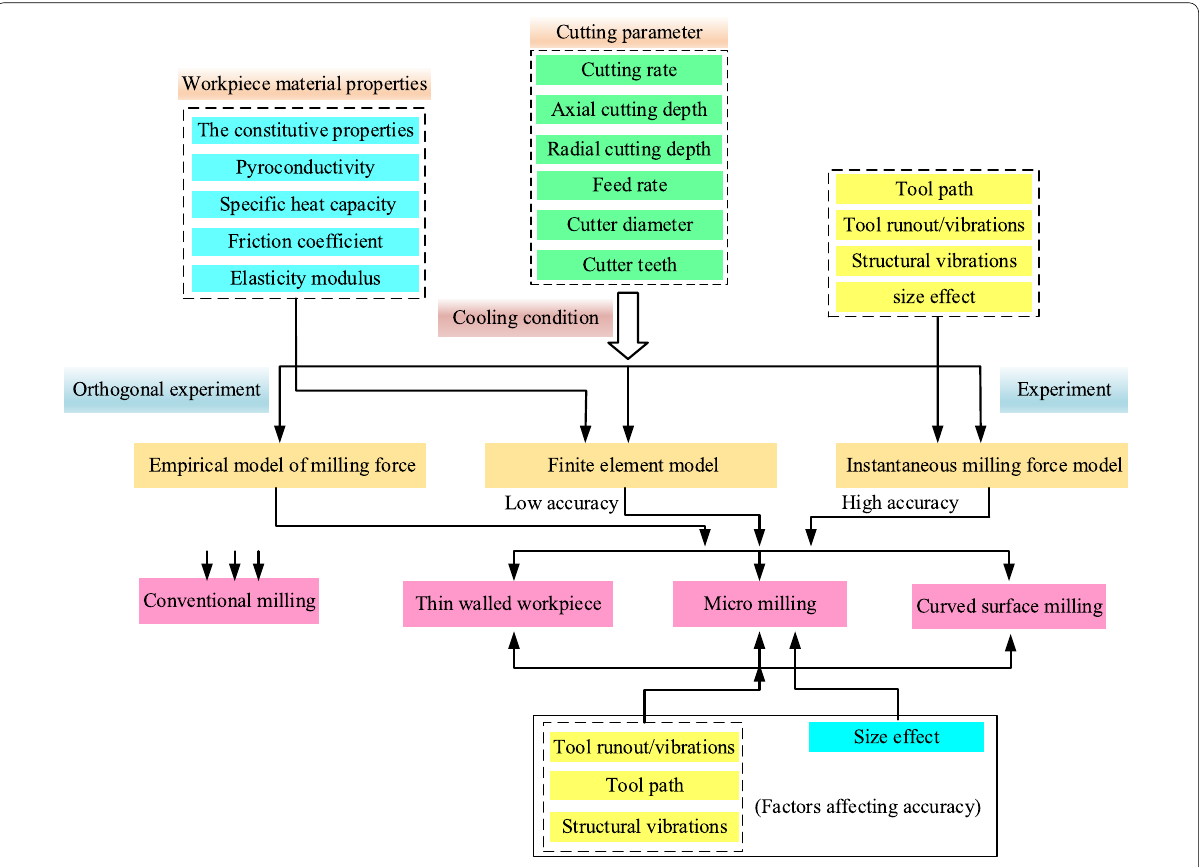
Figure 24 Analysis diagram of milling force